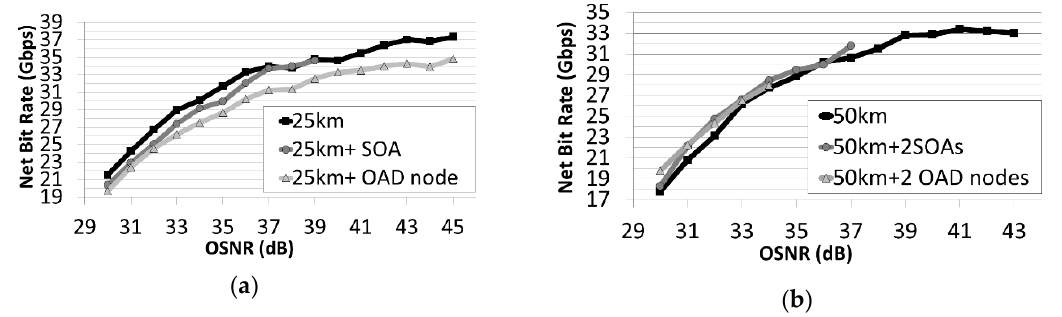
Figure 8. Net bit rate versus OSNR for ( a ) 25 km and ( b ) 50 km for the different scenarios at the target BER.